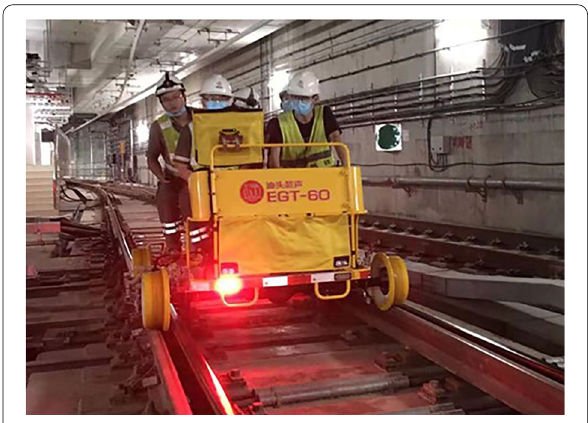
Figure 14 Field operation photo